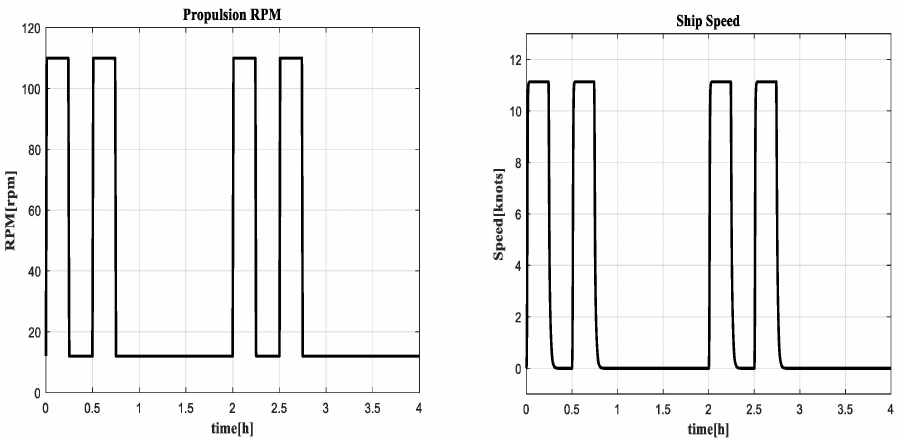
Figure 1. Propulsion RPM ( left ) and vessel speed ( right ) according to the operation profile.